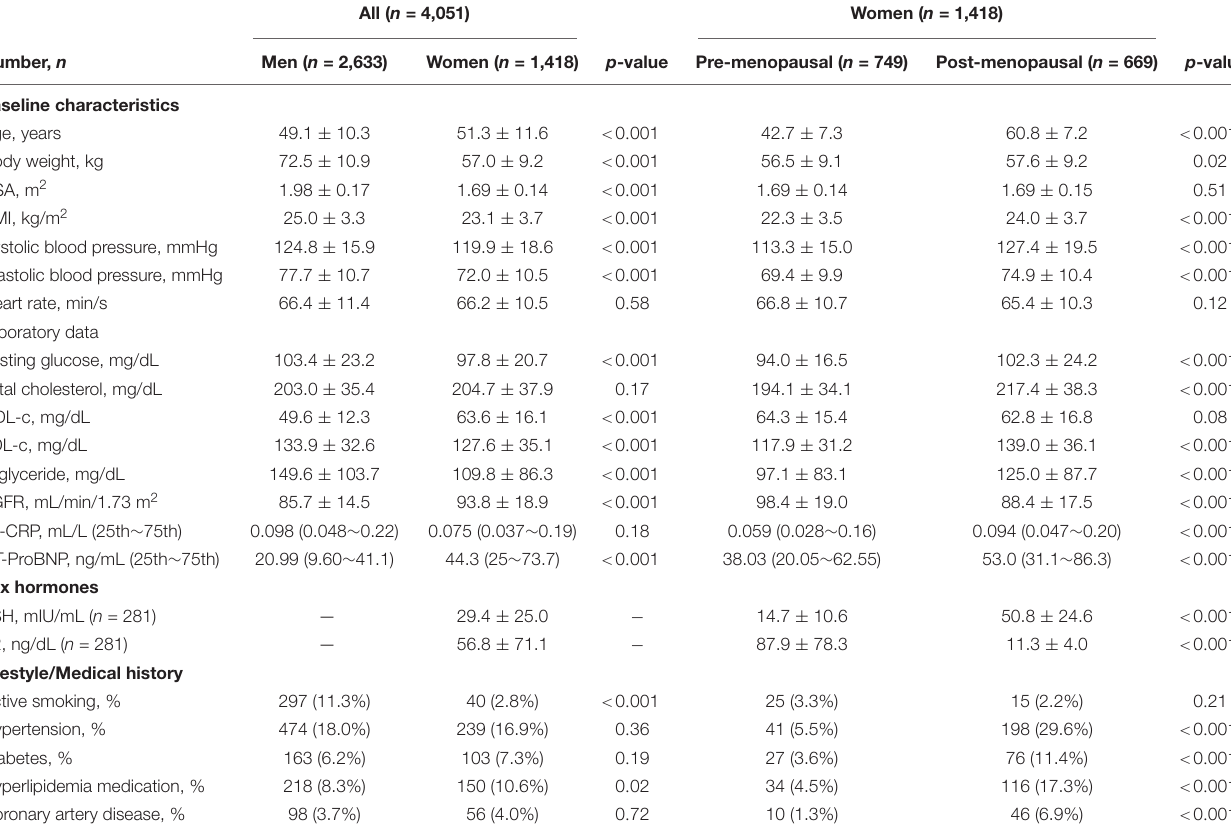
TABLE 1 | Baseline demographic characteristics of study participants, stratified by sex and menopause status. All ( n = 4,051) Women ( n =